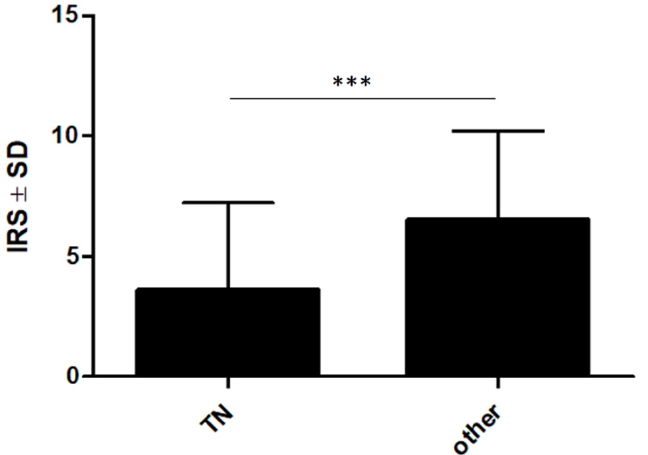
Figure 4. Triple-negative breast cancer (TNBC) cases showed a lower level of NUCB2 expression as compared with that in other molecular subtypes (*** p < 0.001).